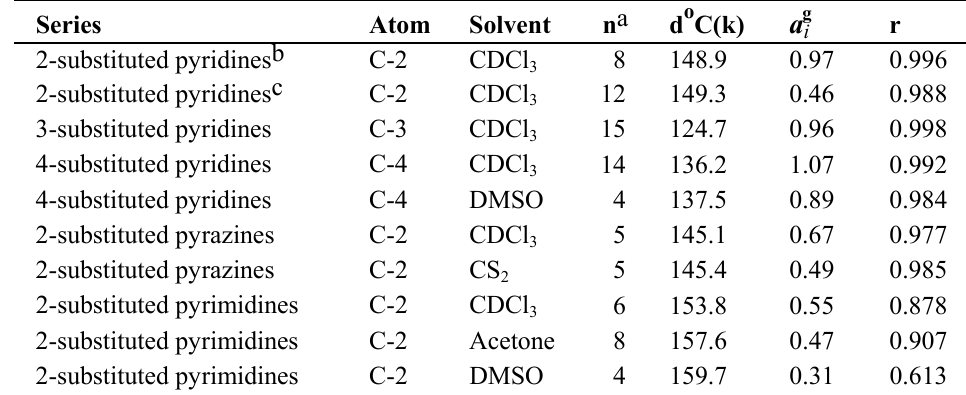
Table 1. Parameters of linear regressions (equation 3) of the chemical shifts of carbon atoms bonded to substituent with A Series